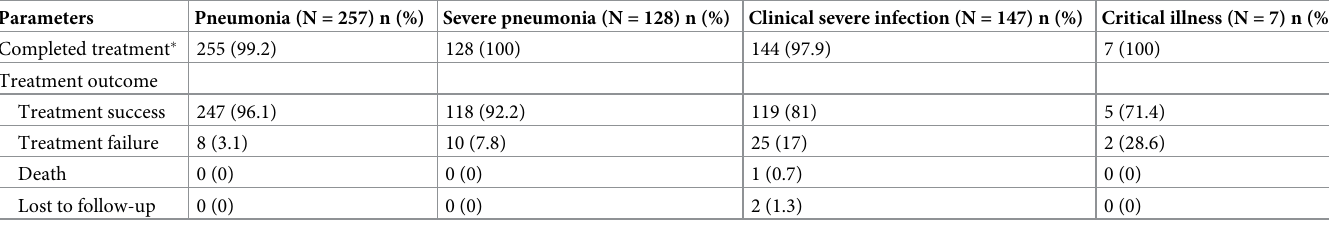
Table 4. Treatment outcomes among sick young infants who received outpatient treatment at health centres.